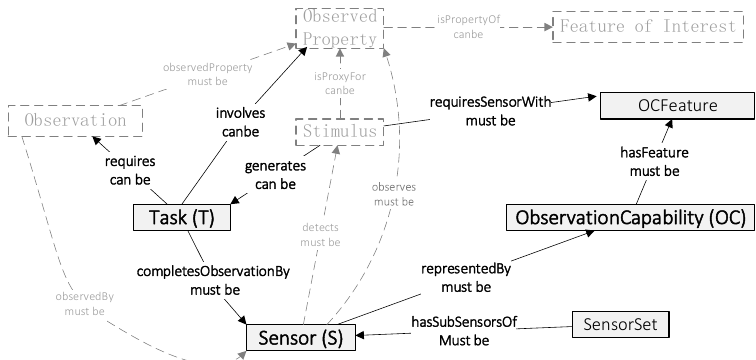
Figure 2. The core concepts and relations forming the Task-Sensor-ObservationCapability ontology design pattern considering and integrating the SSN ontology.